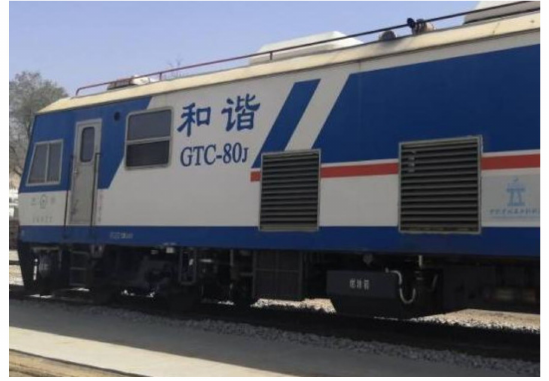
Figure 7. GTC-80J rail inspection